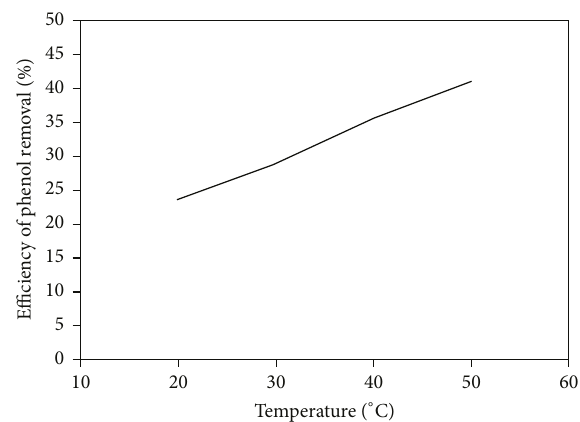
Figure 6: Effect of solution temperature on the percentage removal of total phenolic compounds. Operation conditions: 10mL of OMWW, mass of activated bentonite = 1.0g, and contact time = 3 hrs.